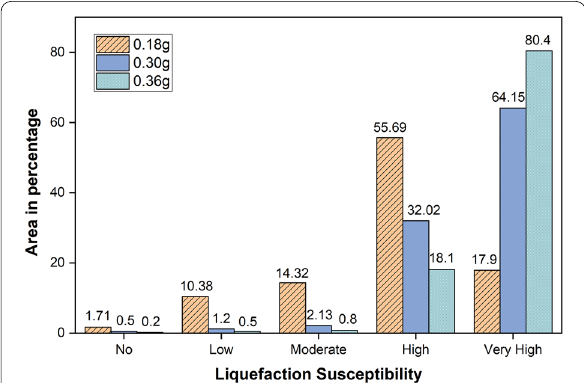
Fig. 12 Area in percentage of liquefaction susceptibility based on liquefaction potential index (LPI) in three scenario earthquakes: M w